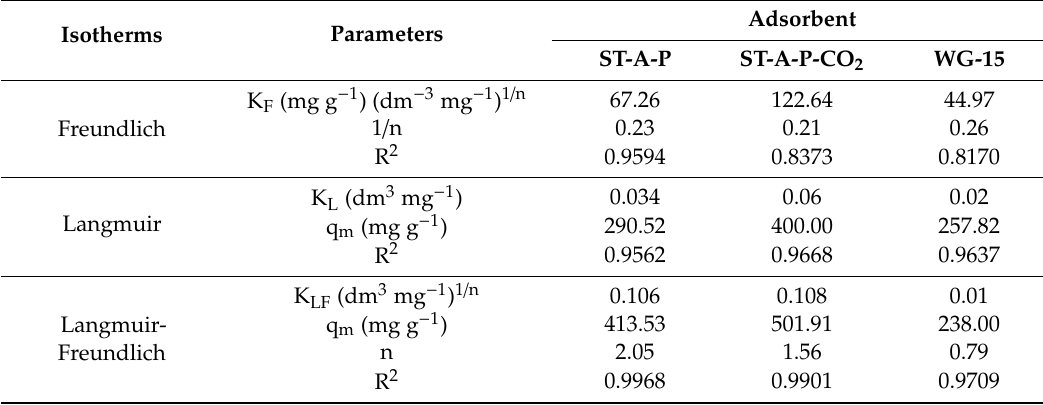
Table 9. Langmuir, Freundlich, and Langmuir-Freundlich equations parameters and correlation coefficients R 2 for the adsorption of naproxen on the studied adsorbents.